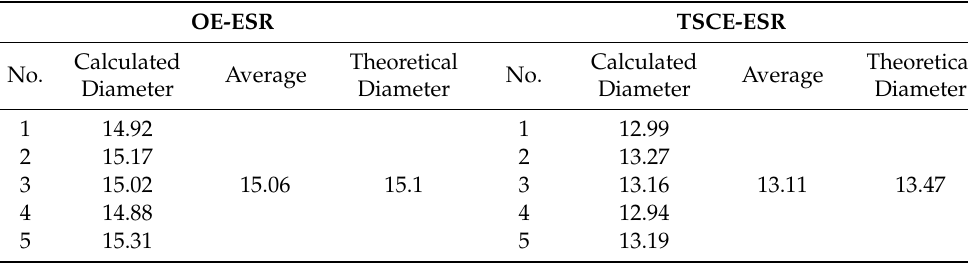
Table 3. The calculated and theoretically predicted diameter of